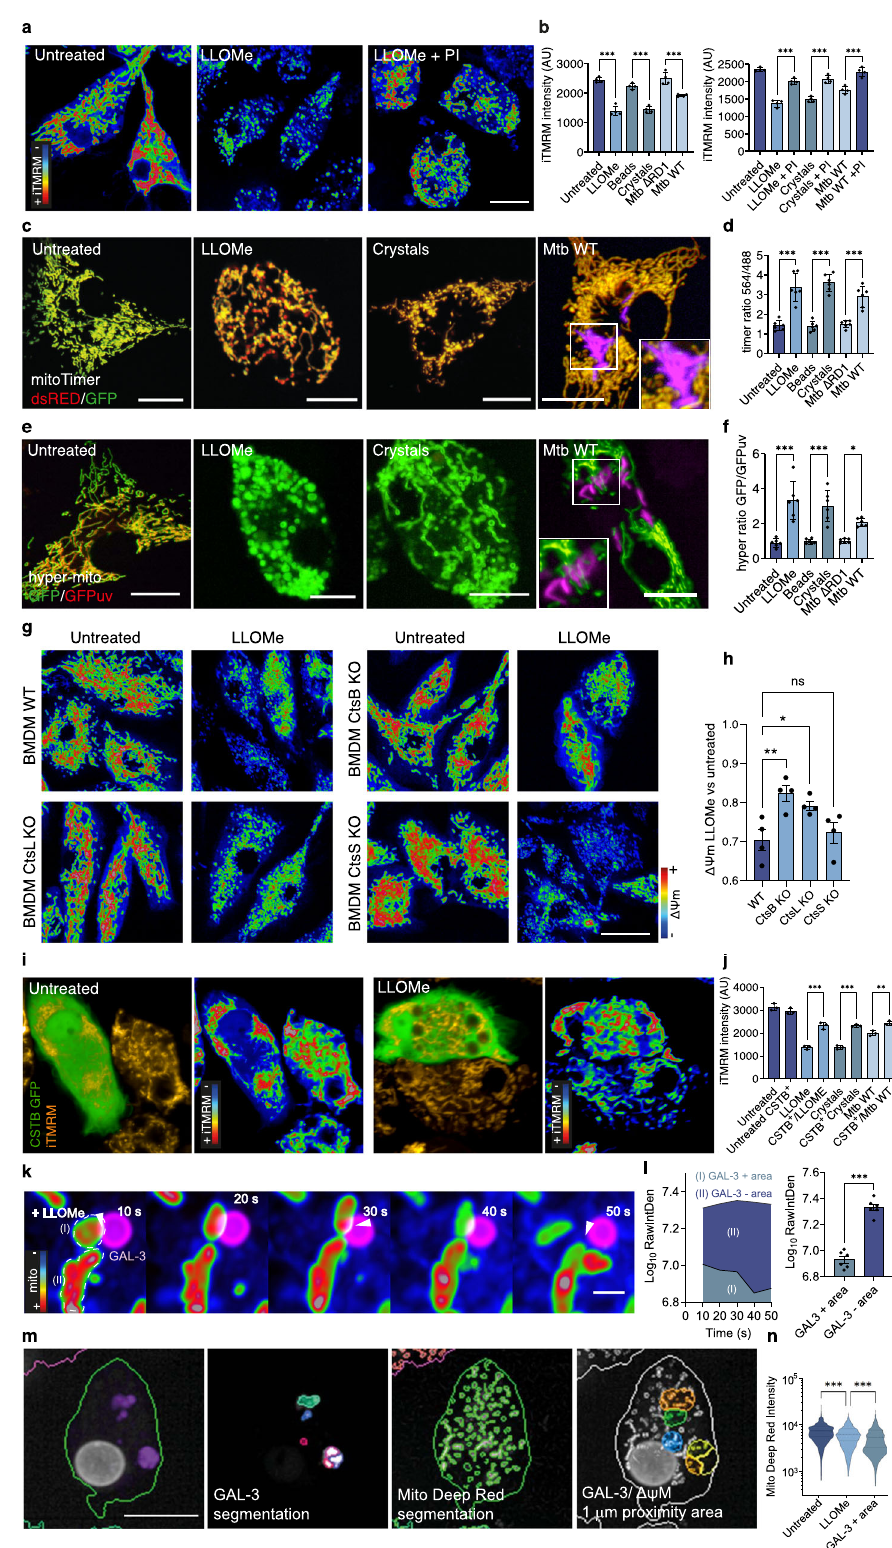
(Fig. 4e and SupplementaryFig. 6c), indicating thatthe enlargement of lysosomes increased the duration of M-L contacts. We found that the decrease in mitochondrial activity after endomembrane damage occurs at earlier time points in macrophages expressing EGFP-Rab7, EGFP-Rab7Q67 or LAMP-1-mNeonGreen (Fig. 4f – h). Intriguingly, simi- lar results were observed when mitochondrial activity was tracked